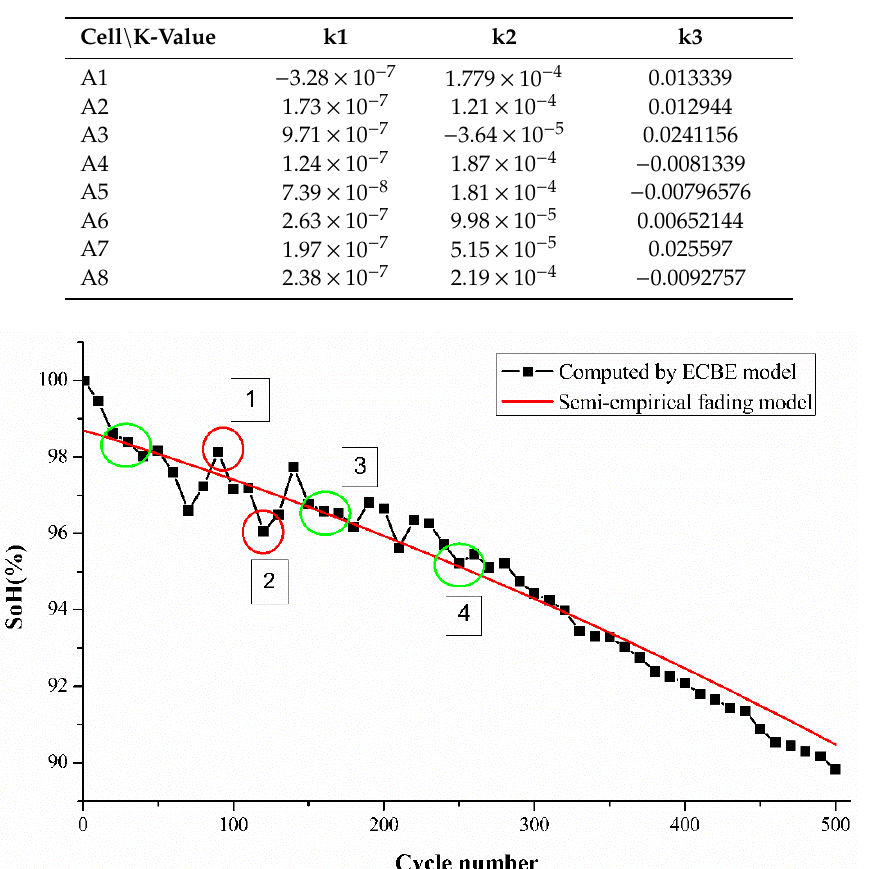
Table 3. The parameters of k1, k2, and k3 are calculated from the SoH formula.